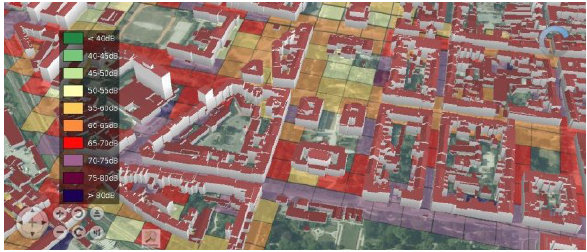
Figure 4. Dynamic noise map on the web platform with a 3D model